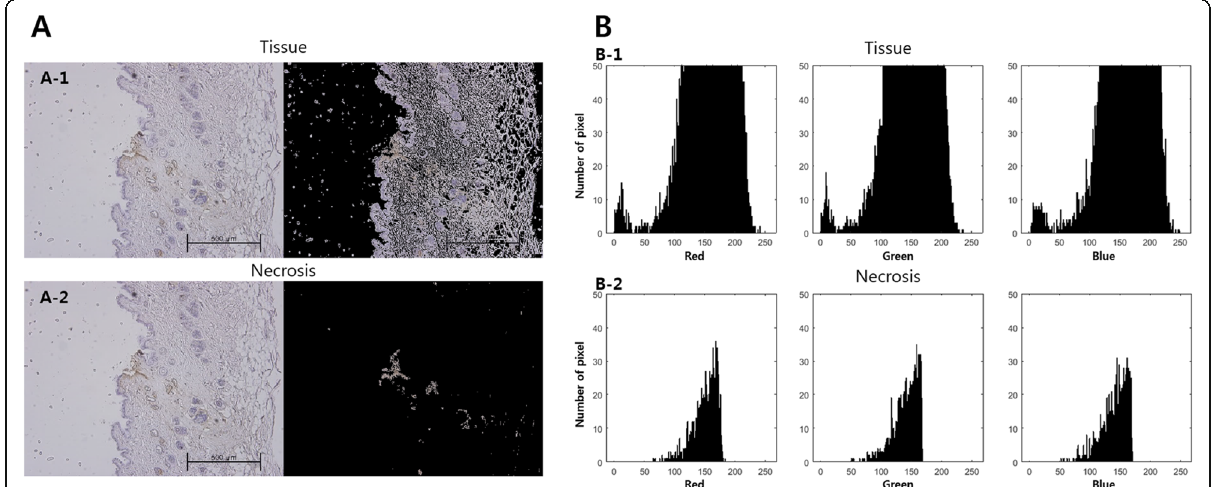
Fig. 1 Quantitative analysis of tissues with necrosis. a . Photographs of tissues showing pixels (A-1) and tissue with necrosis showing pixels (A-2). b . Graphs showing RGB (red, blue, green) values and number of pixels of the whole tissue (B-1) and RGB values and number of pixels of the tissue with necrosis (B-2). The RGB values of the tissue with necrosis are shown in B-2, and the presence of tissue necrosis was determined by the number of pixels based on Fig. 1